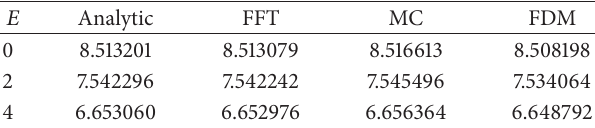
Table 2: Comparing several methods for American option pricing. 𝐸 Analytic FFT